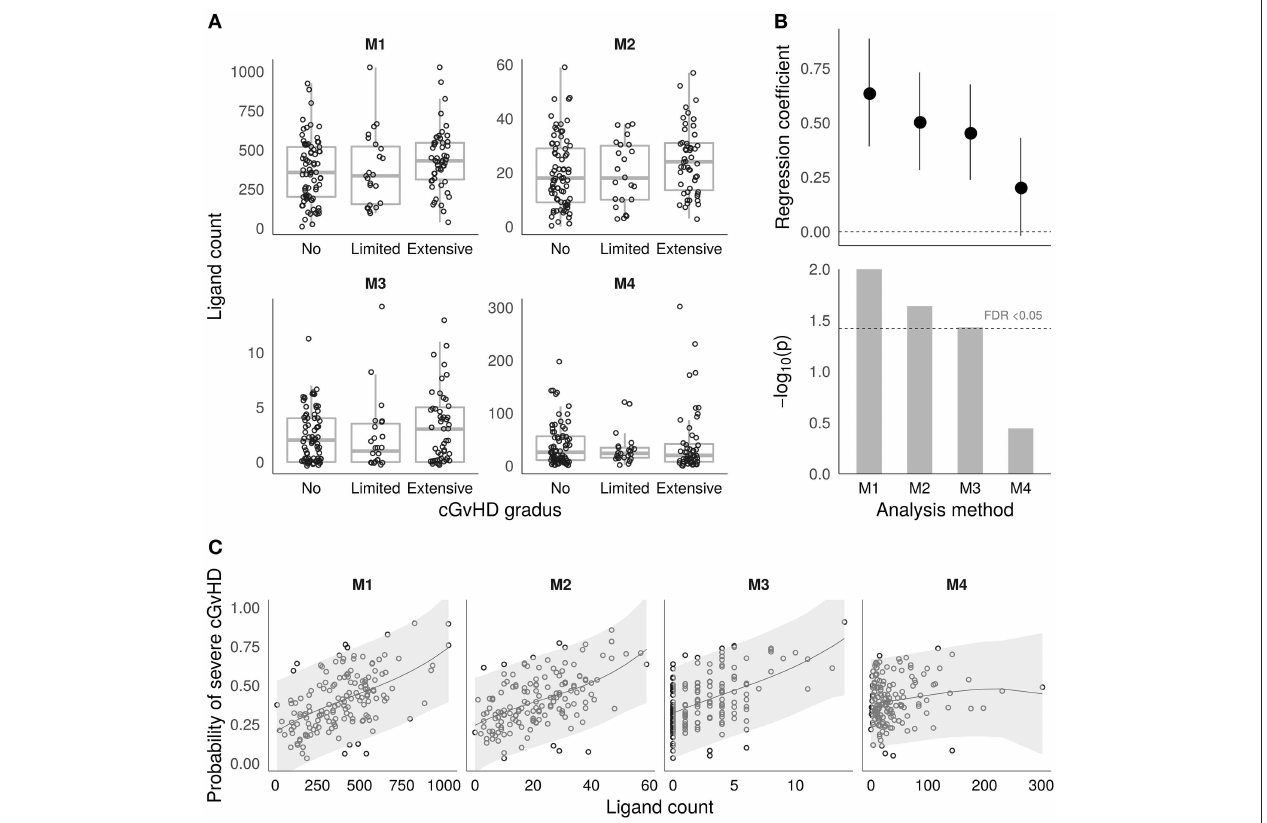
FIGURE 2 | Alloimmunity estimates and associations with chronic GvHD. (A) Boxplots showing the distributions of the four different HLA ligand estimates (M1–M4) based on recipient-mismatched peptides (see the Methods section and Table 2 for a detailed description). The y-axis shows the estimated ligand count, and the x-axis shows the cGvHD grades. (B) Logistic regression coefficient estimates with ± 1S.E. (top) and p -values (bottom) from the models testing the associations for cGvHD grades “no” ( n = 77) vs. “extensive” ( n = 51) in the four methods M1–M4. The coefficients are calculated based on scaled and centered ligand count values to make them comparable between M1–M4. The FDR < 0.05 threshold is shown by the dashed horizontal line in the lower panel. (C) Estimated probabilities for severe chronic GvHD vs. the number of mismatched ligands as given by the fitted logistic regression models for M1–M4. The shaded areas visualize the 95% confidence intervals for